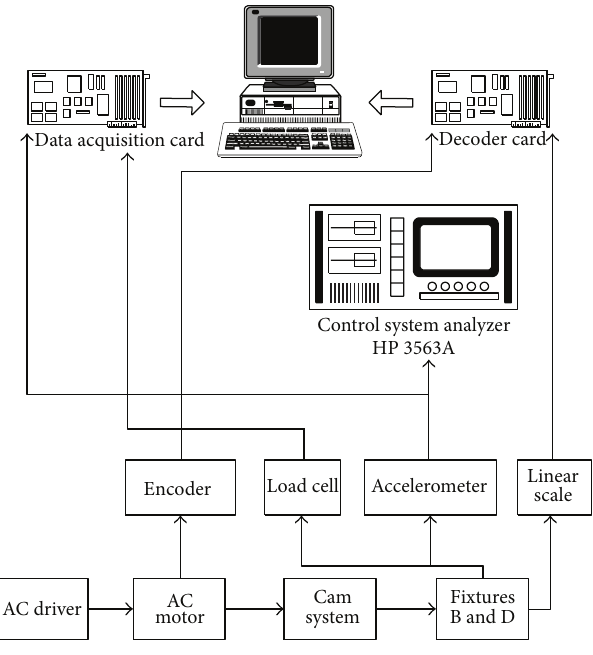
Figure 4: Experimental